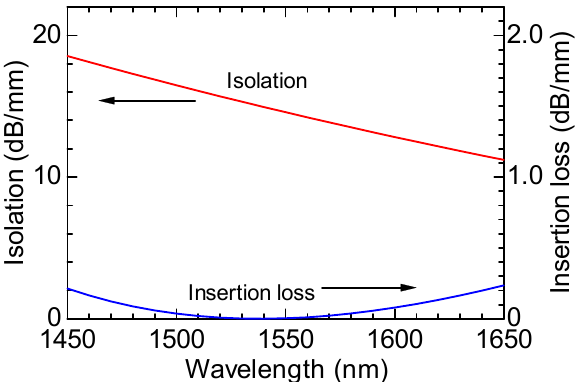
Figure 11. Calculated dependence of isolation and insertion loss on a wavelength in the semileaky waveguide optical isolator, where the thickness of the Ce:YIG guiding layer and the offset angle of the LiNbO crystal axis are set to be 1.19  m and 20°, respectively 3